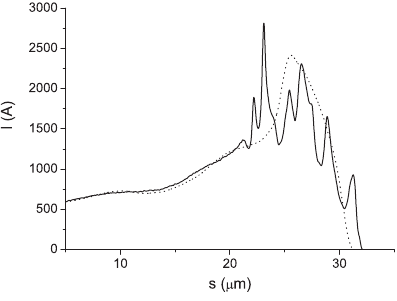
FIG. 8. Modulation of current in the head of electron bunch lasing at 7 nm in the VUV undulator of FLASH and passing FIR undulator with R 56 equal to 250 (cid:4) m (solid), and with R 56 ¼ 0 (dots). Only the small part of the bunch is shown; the bunch head is on the